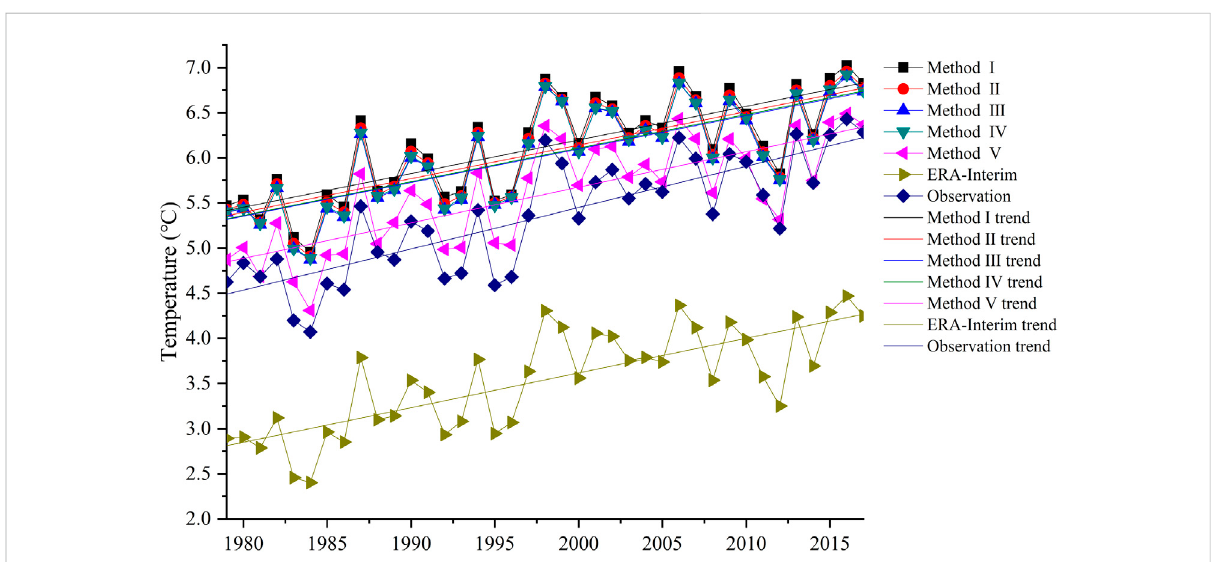
FIGURE 4 Inter-annual variability and warming trends in the QLM temperatures: observed, original ERA-Interim temperature, and corrected using fi ve lapse rates, during the period 1979 ‒